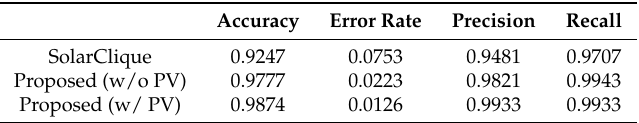
Table 7. Fault detection comparison with SolarClique.